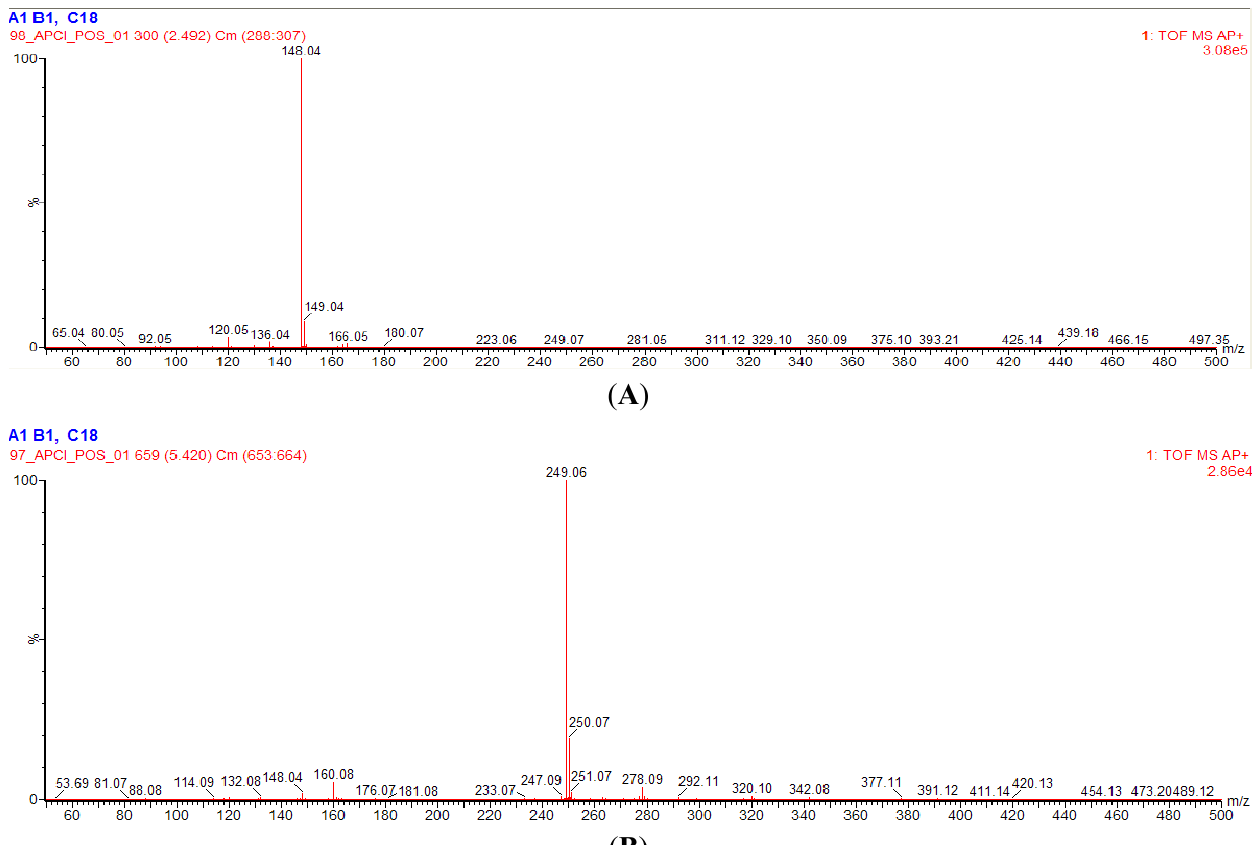
Figure 1. APCI-MS and 1 H-NMR spectra of the anti- Staphylococcus compounds (IN-1 and IN-2) purified from the EA-extract of indigo naturalis; ( A ) APCI-mass spectrum of the compound IN-1; ( B ) APCI-mass spectrum of the compound IN-2; ( C ) 1 H-NMR ); ( D ) 1 H-NMR spectrum of the spectrum of the compound IN-1 (400 MHz, acetone- d 6 compound IN-2 (400 MHz, acetone- d 6